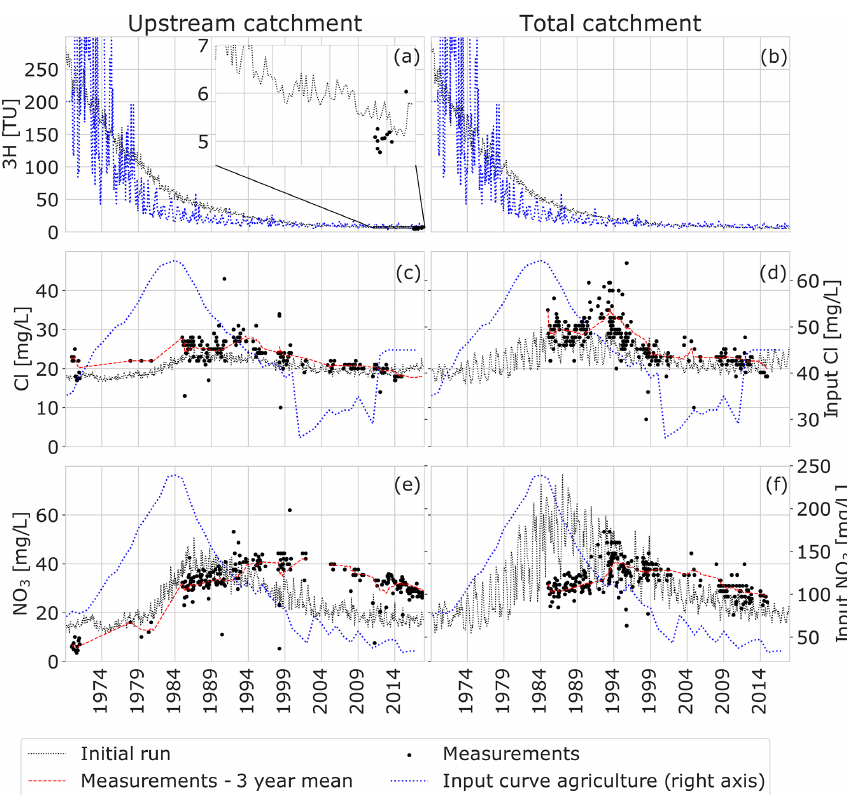
Figure 4. Measurements, agricultural input time series, and initial model results based on the TTDs from Kaandorp et al. (2018a) and the solute input time series in Fig. 3. On the left, tritium (a) , chloride (c) , and nitrate (e) are shown for the upstream part of the catchment; on the right, tritium (b) , chloride (d) , and nitrate (f) are shown for the total catchment (downstream). Note that tritium samples were only available for the upstream part of the catchment (a)